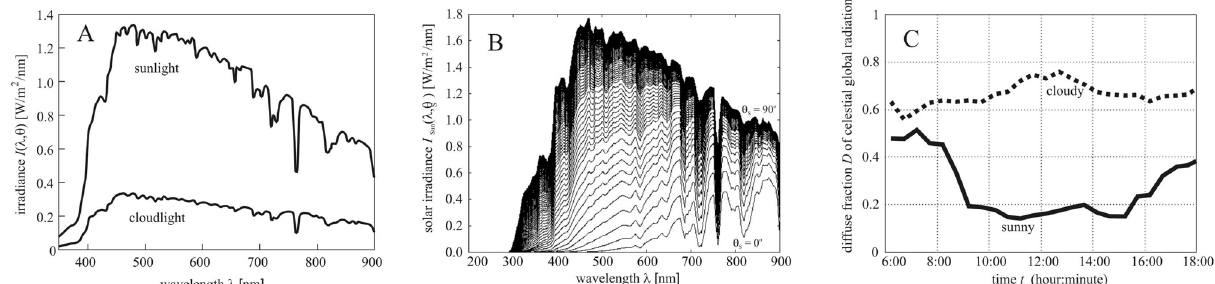
Figure 8. Meteorological data used in the computations. ( A ) Spectral distribution of irradiance I sun (λ, θ s ) for direct sunlight measured under cloudless sky conditions at solar noon with solar elevation angle θ s = 53.5° and I cloud (λ) for cloudlight measured on a completely overcast day at solar noon with solar elevation θ s = 53.8° (after Fig. 2a of Dengel et al. 32 ). ( B ) Spectral distribution of irradiance I Sun (λ, θ s ) of direct sunlight as a function of solar elevation angle θ s ranging from 0° (horizon, lowermost curve) to 90° (zenith, uppermost curve) with an increment of 1° simulated by MODTRAN 3.7 (Ref. 33 ). ( C ) Diurnal variation of the annual mean diffuse